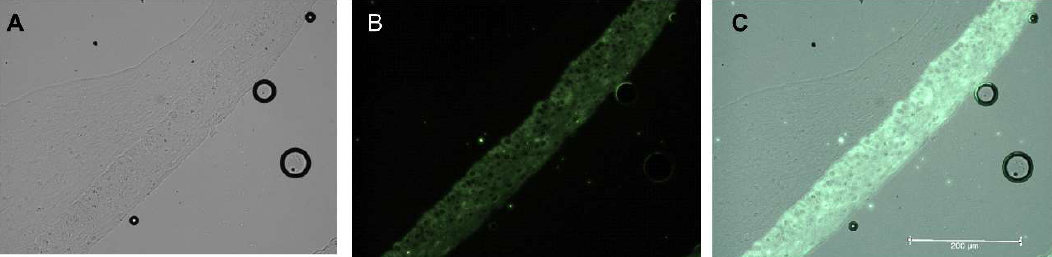
Figure 3. Human skin equivalent generated using PCS-200-010, PCS-200-013, and PCS-201-010 cell lines and differentiated for 14 days. Formalin-fixed, paraffin-embedded 3-dimensional (3D) skin models. Fluorescent immunostaining. Green—Cytokeratin 14 (Abcam ab77684). Melanocytes are seen as the dark color of the entire surface of the epidermis (green) layer. ( A ) brightfield, ( B ) Cytokeratin 14 (green), ( C ) merge.